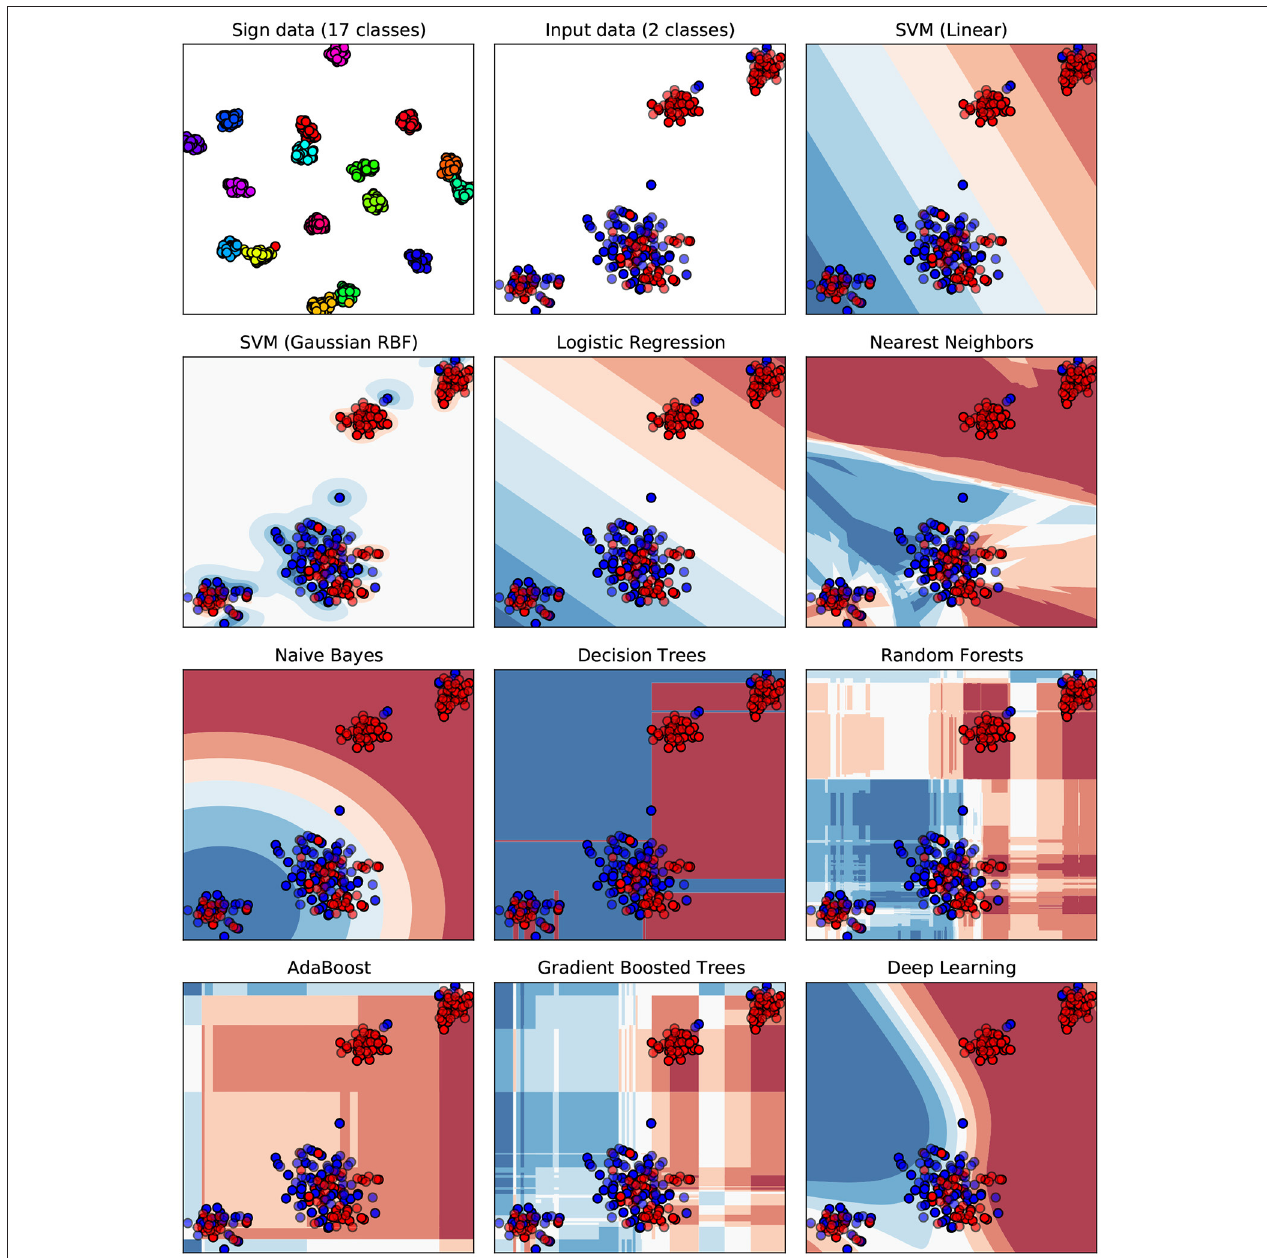
FIGURE 10 | A visualization of decision boundaries for the ML classifiers. The feature space of 176 dimensions (features) is mapped to the 2d Euclidean space using t-SNE dimensionality reduction. Each dot represents the input feature vector of one sample from the data set. Classes are color-coded (red = healthy, blue = suspicious), solid points are training samples, while testing samples are semi-transparent. The Sign data set (Almaksour et al., 2010) with its 17 classes is included as reference, to give an example of an easily separable data